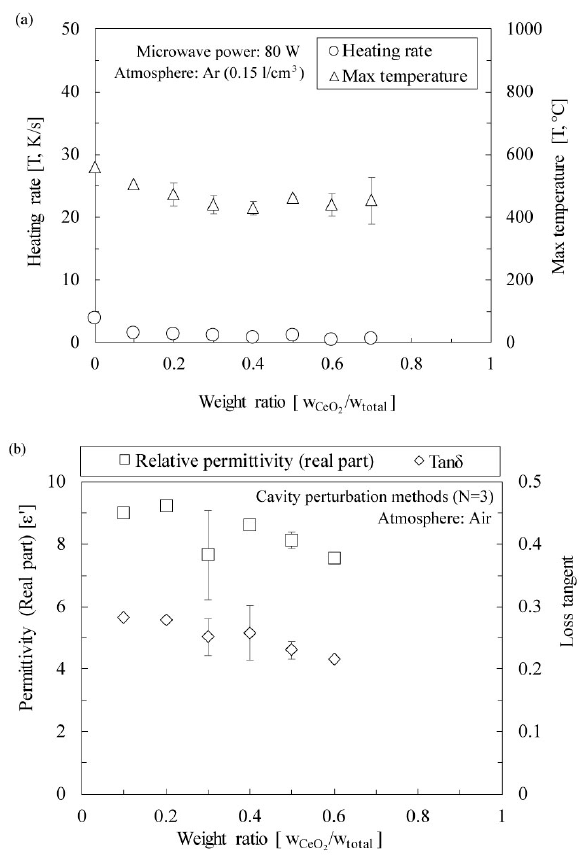
Figure 2. CeO 2 composition dependence of ( a ) heating rate and maximum temperature, and ( b ) electrical permittivity ( ε′ ) and loss tangent (tan δ ). The error bars indicate one standard deviation (N = 3). The SiC fiber-ZrO 2 mixture showed different characteristics (Figure 3). The heating rate, maximum temperature, and dielectric loss tangent all exhibited a maximum value at W ZrO2 /W total = 0.3. The heating rate and maximum temperature increased with the ZrO 2 content at weight ratios of ≤ 0.3, while they decreased at weight ratios of ≥ 0.3 (Figure 3a). A similar tendency was observed for the dielectric loss tangent, as shown in Figure 3b. As the weight ratio of ZrO 2 increases from 0 to 0.3, the amount of SiC fiber in the sample decreases. However, at these low ZrO 2 contents, the loss tangent, which represents the MW absorption behavior of the mixed powder, increases with the amount of ZrO 2 . We surmise that this increase arises from the effects of small plasma generation on the contact surface or heat conduction. However, this hypothesis cannot explain the fact that both, the loss tangent and heating rate, exhibit a maximum value at the weight ratio of 0.3 because the MWs in the cavity perturbation method for the loss tangent is too weak to generate the plasma.